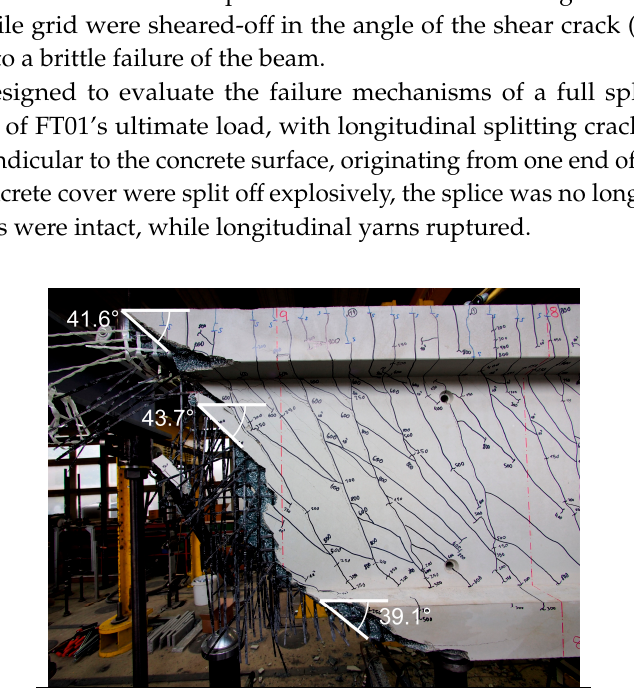
Figure 8. Failure of FT01: ( a ) beam at peak load 0.24 s prior to failure; ( b ) ruptured CFRP bars and secondary rupture of grid reinforcement with spalling of concrete.